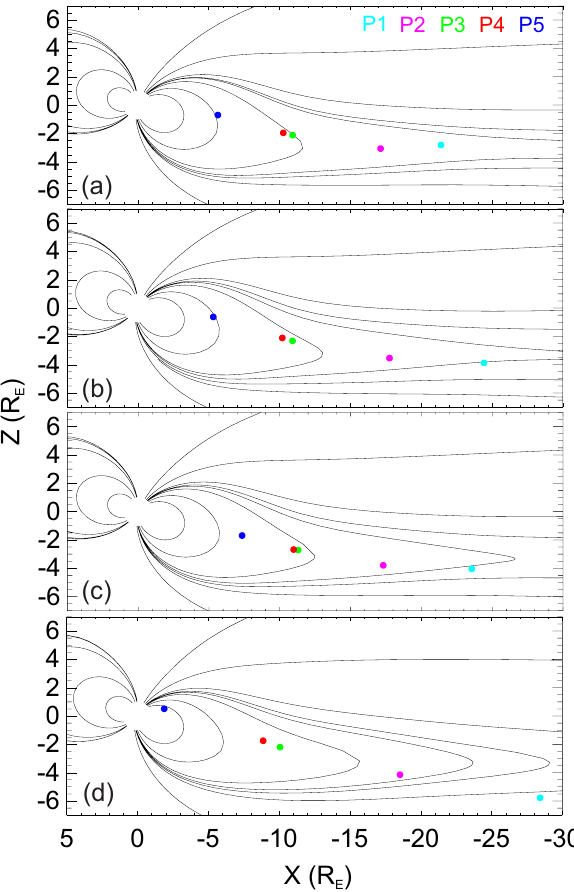
Fig. 1. Positions of the five THEMIS spacecraft for the four events presented in the GSM xz plane: (a) 26 February 2008, 04:53UT, (b) 22 February 2008, 04:37UT, (c) 22 February 2008, 06:26UT, and (d) 14 February 2008, 02:44UT. Also shown are the superim- posed magnetic field lines obtained from the T96 model (Tsyga- nenko,